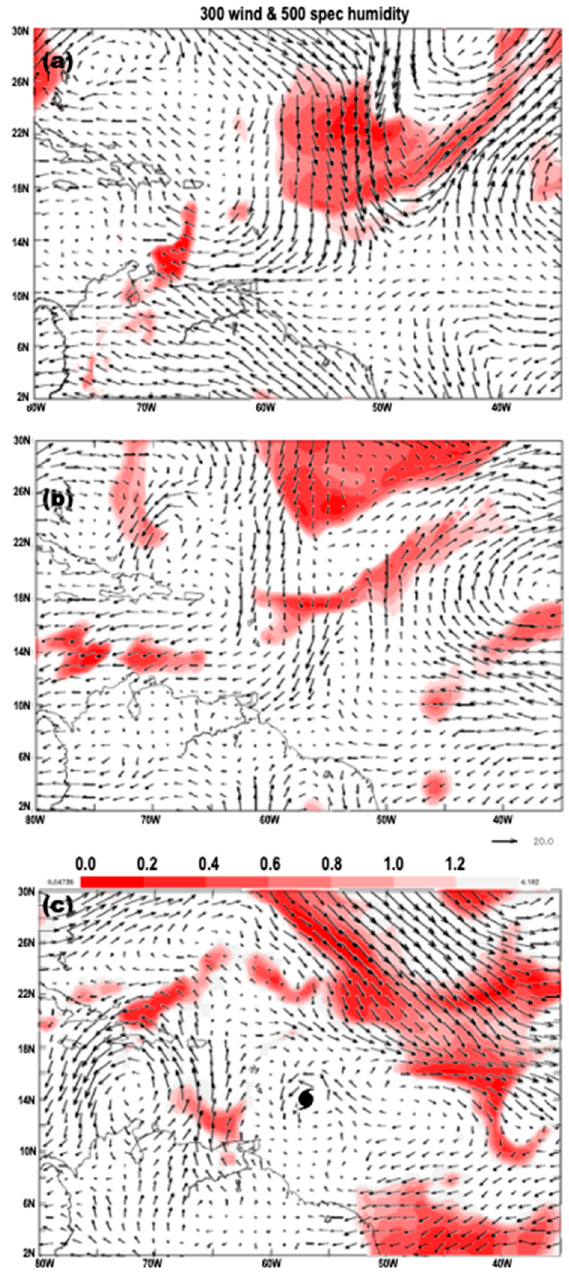
Figure 4. MERRA2 reanalysis fields at ( a ) 0 Z 12 September, ( b ) 15 September 2017, and ( c ) 18 September 2017, of 500 hPa specific humidity (shaded <1.4 g/kg), and 300 hPa wind (vector). Hurricane labeled in ( c ).